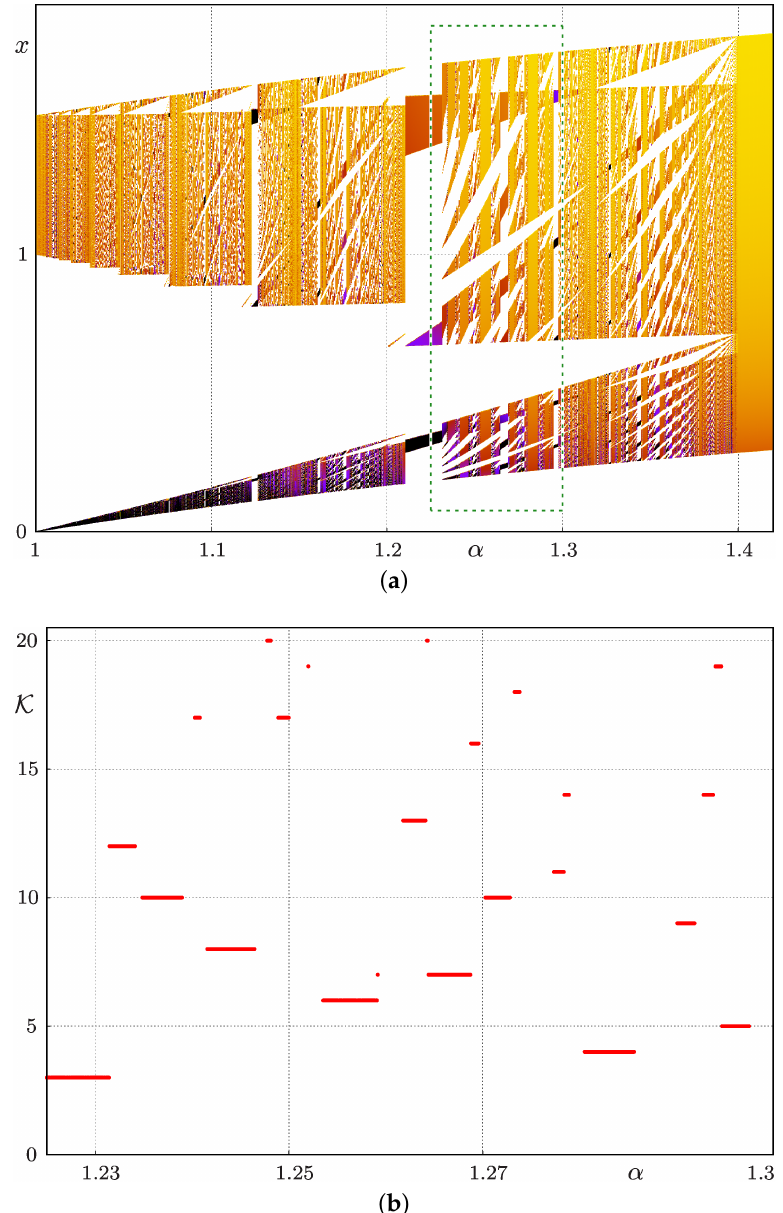
Figure 3. ( a ) The set M ( S ) for various values of parameters α and β = 1.5. ( b ) The number of bands (connected components) of sets M ( S ) for parameter values indicated by the rectangle marked in ( a